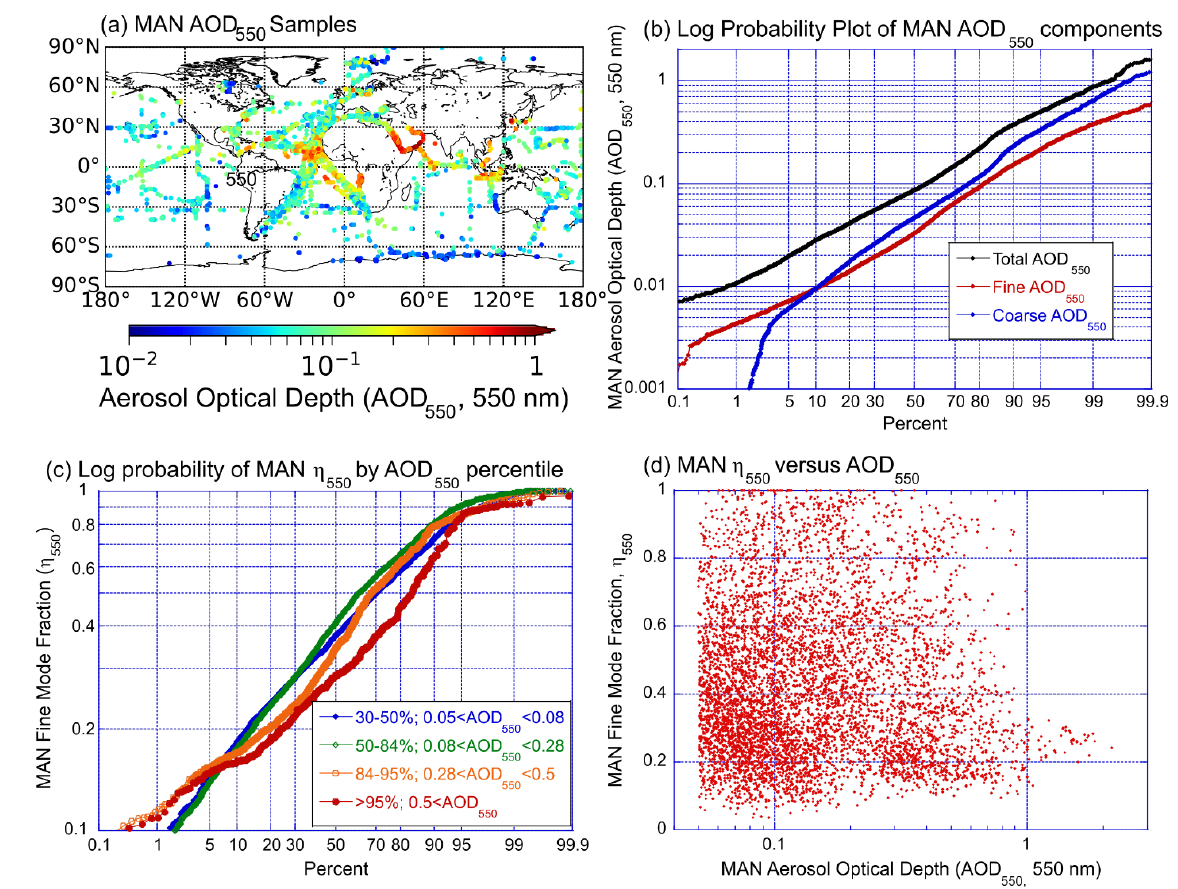
Figure 1. ( a ) Distribution of MAN data points collected from 2016 through 2019 used in this study. Log probability plots of ( b ) all Total AOD 550 MAN data points used in this study and ( c ) SDA modal extraction of η 550 by AOD 550 percentiles. ( d ) A scatter plot of all SDA η 550 versus AOD 550 data points used in the bulk analyses.